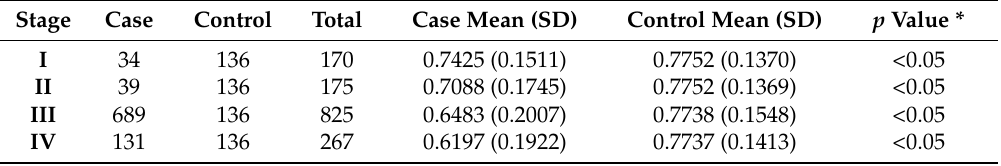
Table 1. Sample number and mean gene set regularity indices for each group. The table displayed the sample numbers, means and standard deviations (SDs) of the gene set regularity (GSR) indices for the four stages and the normal ovarian tissue controls computed through the gene ontology (GO) term gene sets. The gene expression profiles of the 136 normal ovarian tissue samples were utilized as the control group for the stage I–IV groups.